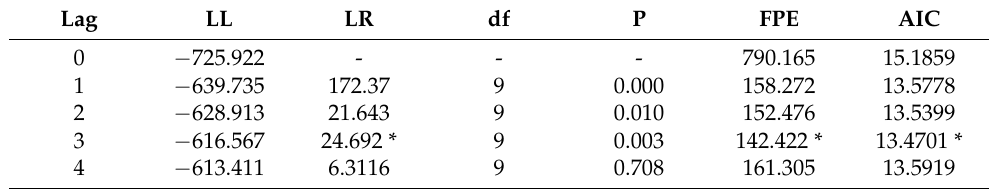
Table 1. Optimal lag length concerning the electricity consumption of the whole of society.